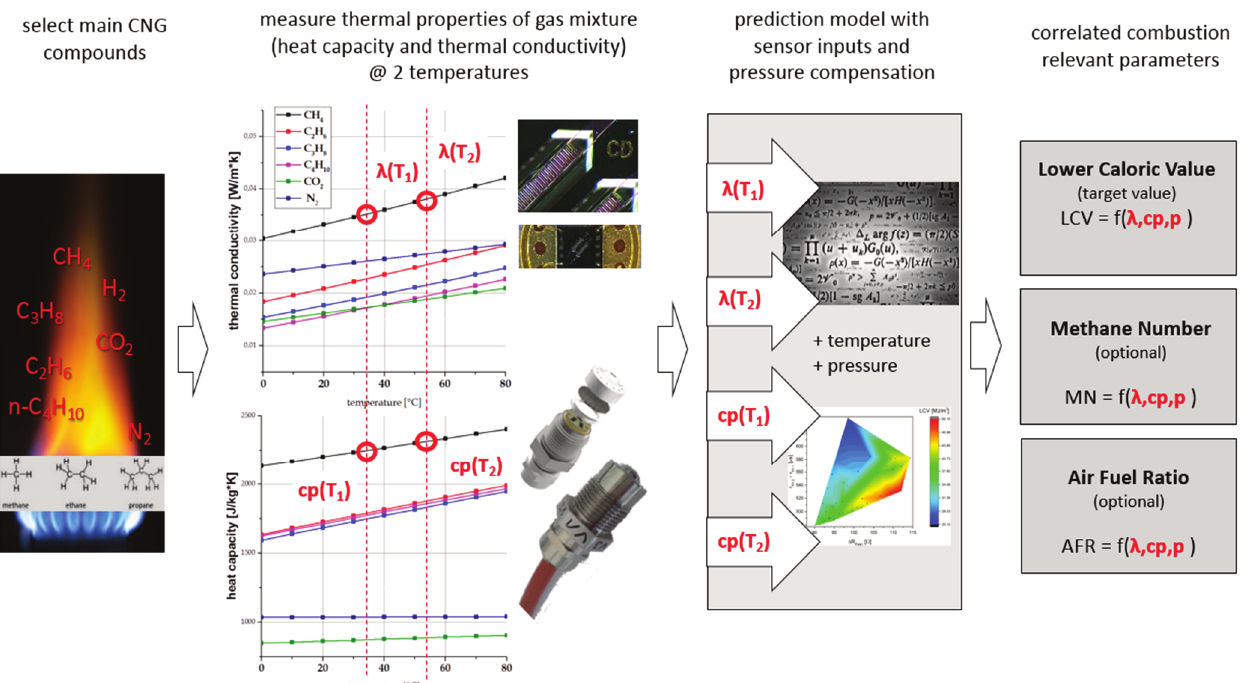
Fig. 4. Concept of the signal propagation of a multiple input correlation setup to predict quality values for